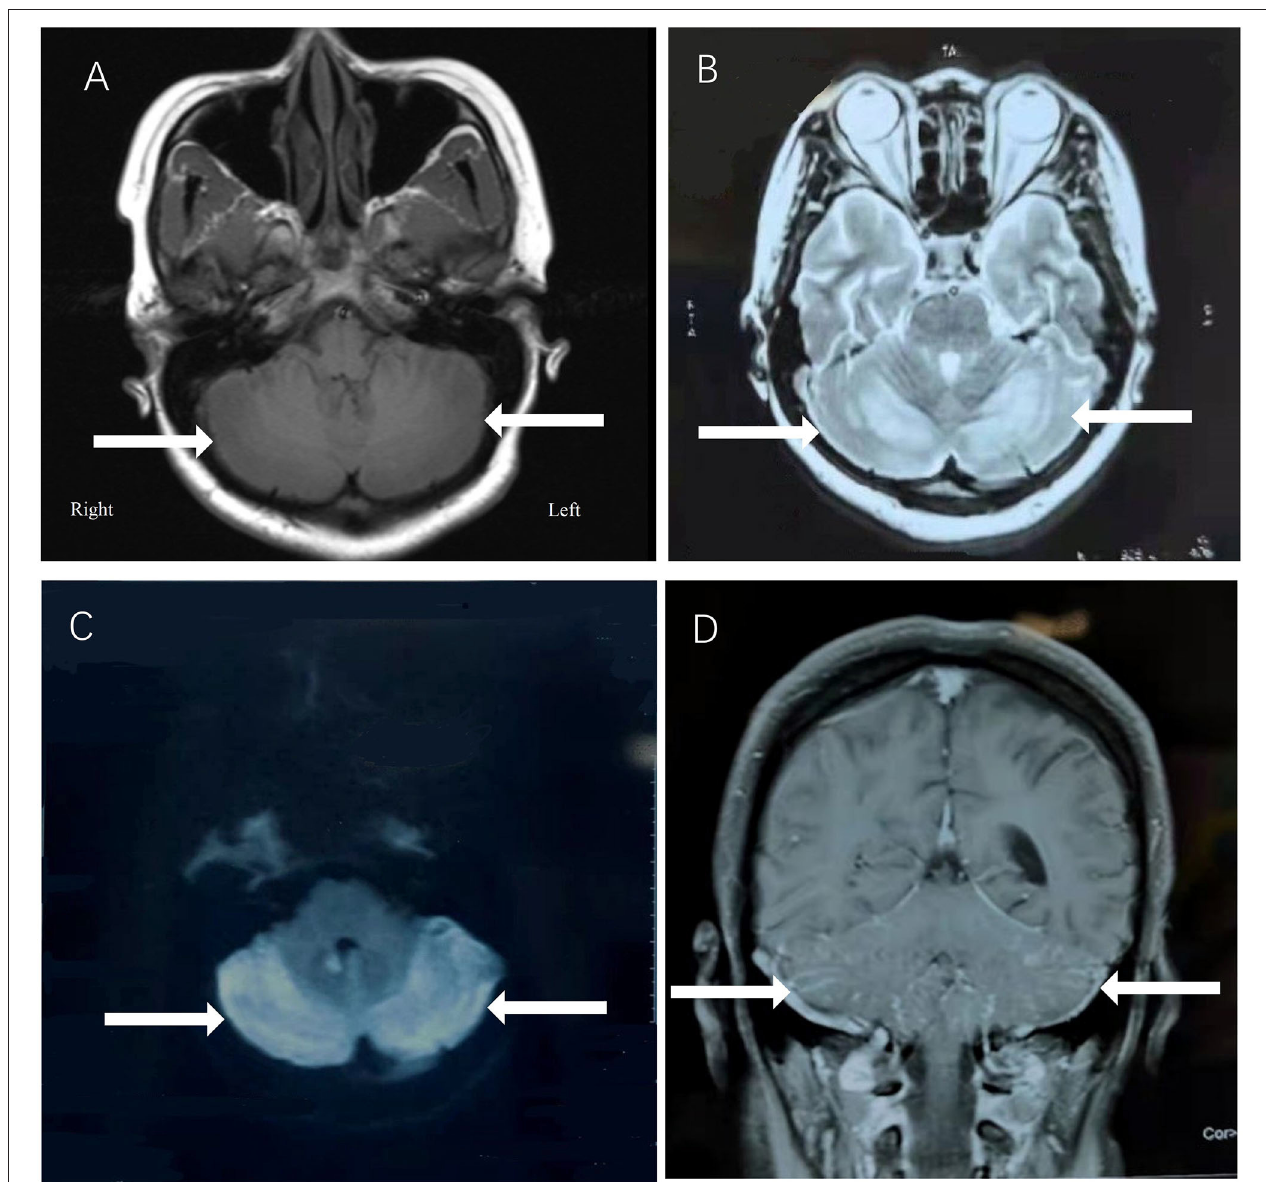
FIGURE 1 | The patient’s brain MRI showed abnormal signals in the vermis and in the bilateral cerebellar hemispheres, with low signal on T1-weighted image (A) , high signal on T2-weighted image (B) , and high signal on DWI sequence (C) with Gd enhancement (D)